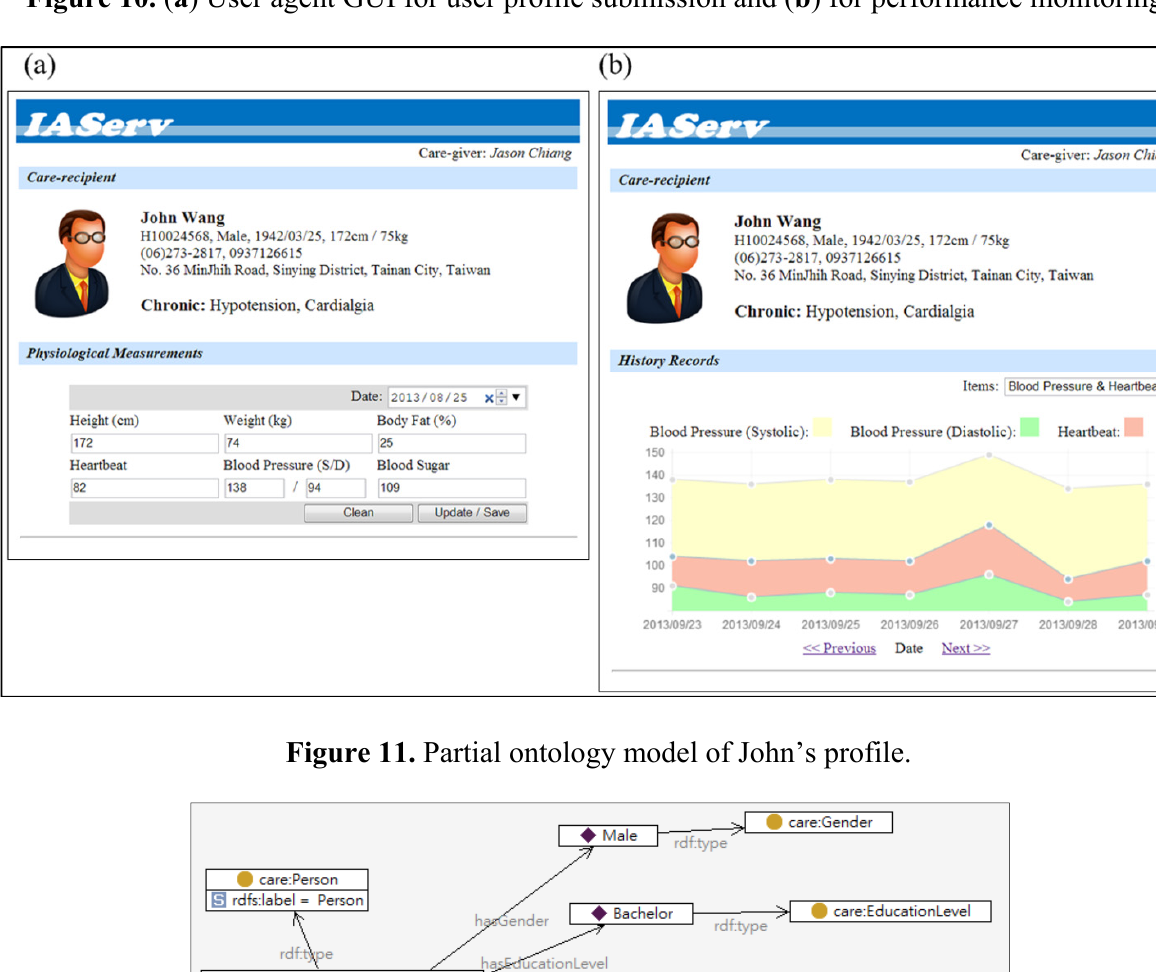
Figure 10. ( a ) User agent GUI for user profile submission and ( b ) for performance monitoring.